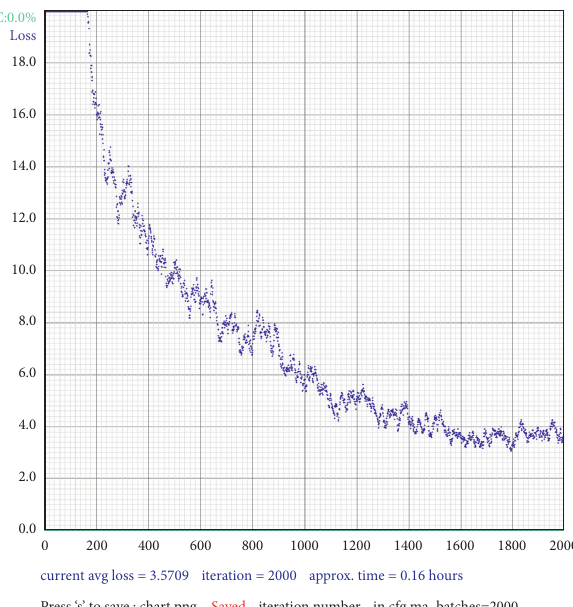
Figure 20: Result of loss function while training YOLOV4.